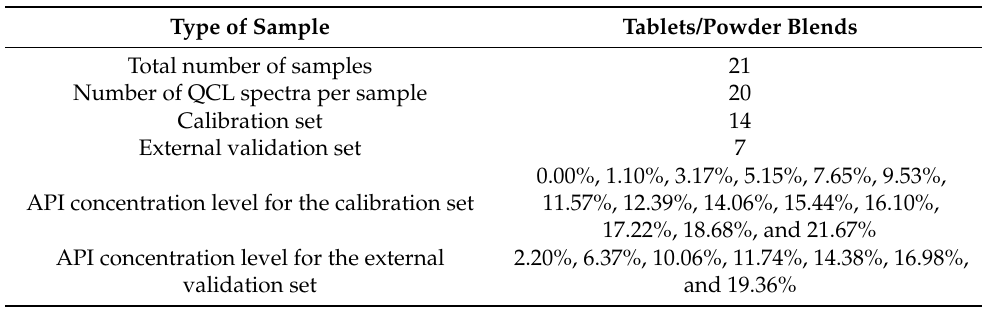
Table 1. Composition of the sample sets used to develop the QCL method used to detect the API in powder and tablet